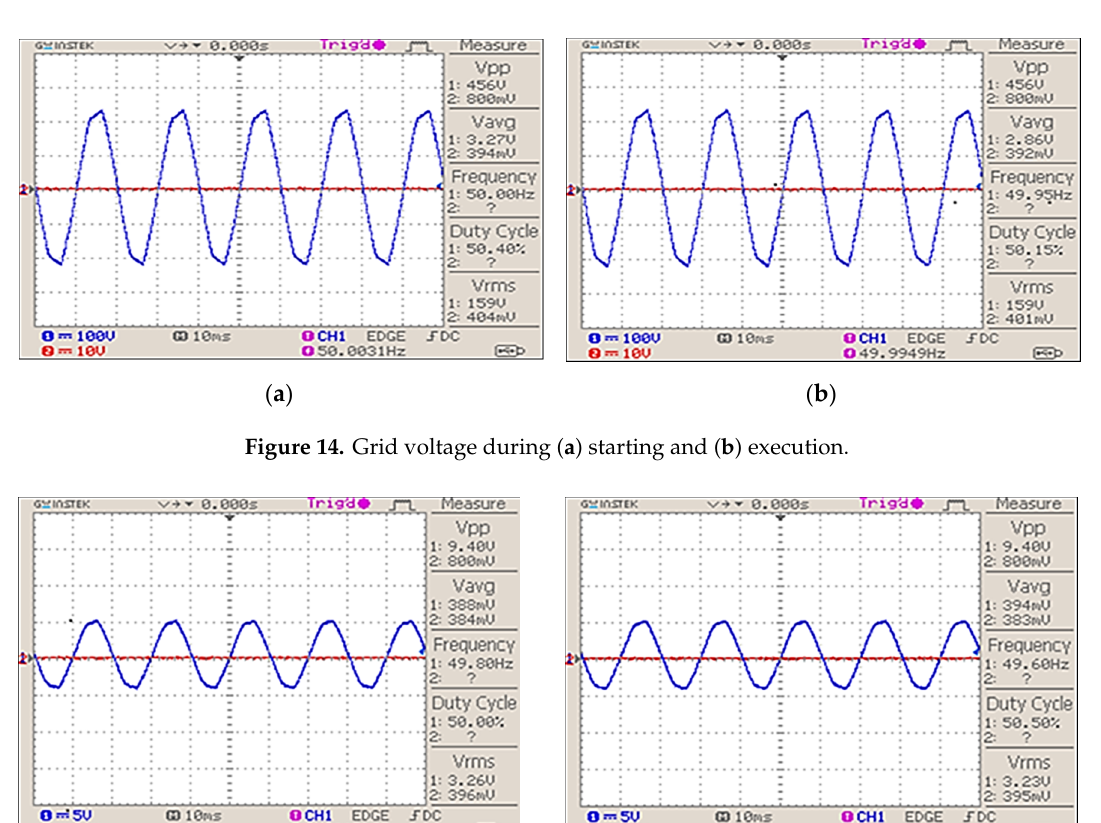
Figure 15. Grid current during ( a ) starting and ( b ) execution.